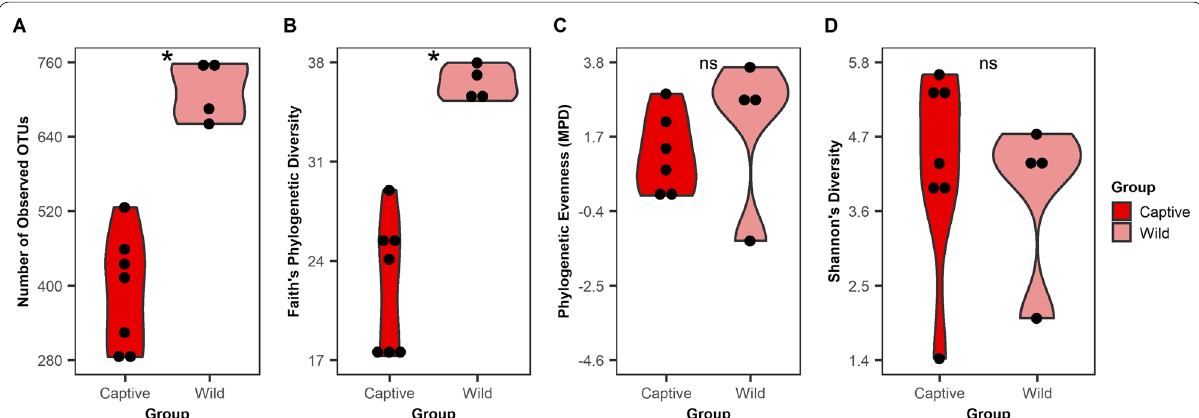
Fig. 1 Alpha diversity of summer Captive and Wild mucosa microbiotas. Violin plots display four alpha diversity metrics: A the number of observed OTUs, B Faith’s phylogenetic diversity, C phylogenetic evenness (MPD), and D Shannon’s diversity. An asterisk indicates a significant difference (adj P < 0.05) and “ns” indicates no significant difference (adj P > 0.05). Adjusted p -values were calculated from t-tests followed by false discovery rate correction with the Benjamini–Hochberg